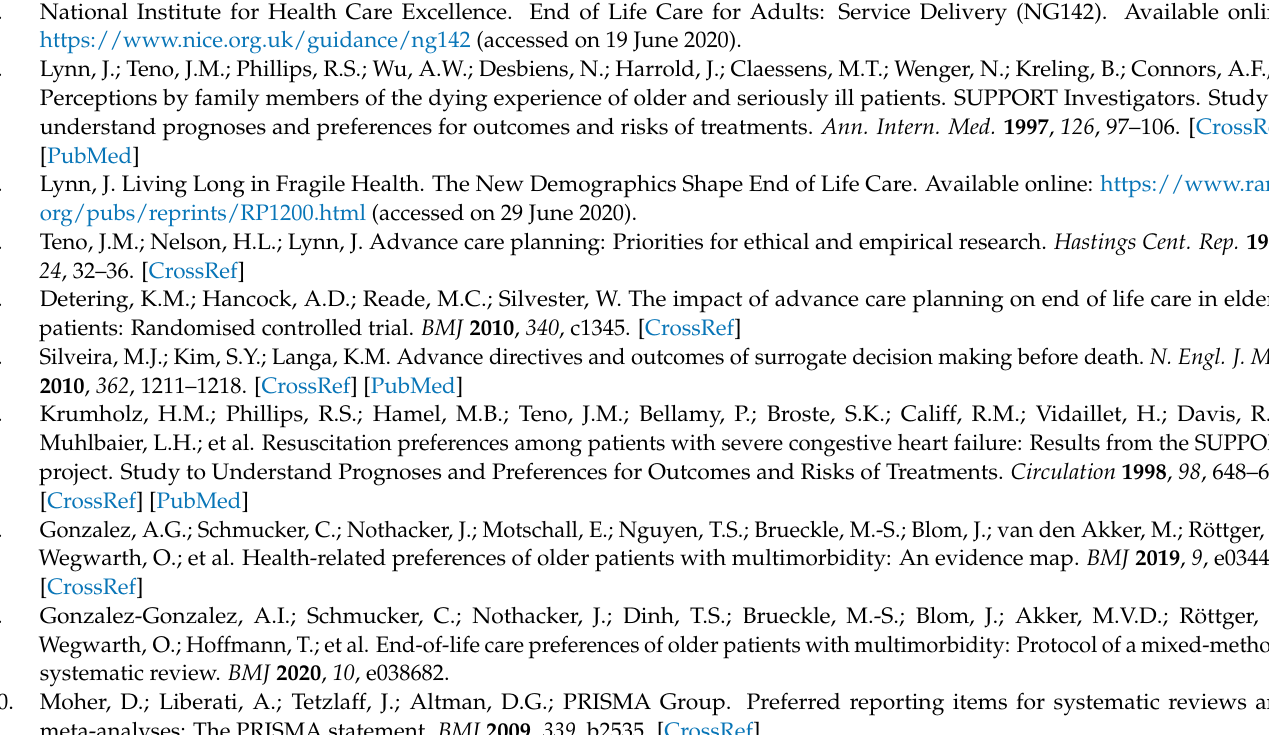
(PRISMA) checklist, Table S2: Search for End-of-Life Care Preferences, Table S3: Excluded studies and reasons for exclusions, Table S4: Quality appraisal of included studies using the MMAT. Figure S1: PRISMA 2009 Flow